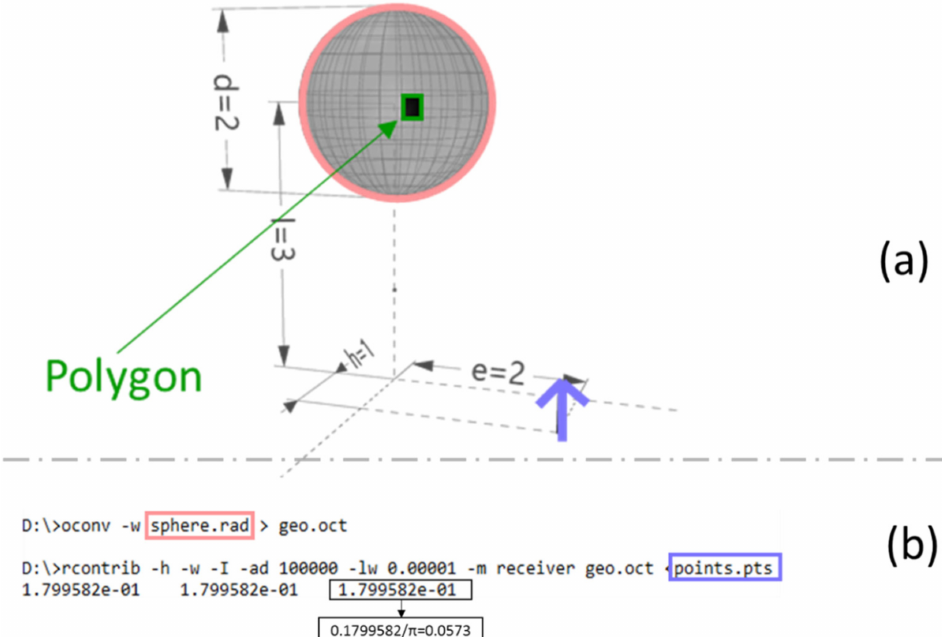
Figure 13. View factor between a differential planar element and a sphere as shown in ( a ) with the corresponding calculation in ( b ). The sphere considered for the calculation is comprised of 595 polygons. The sphere in ( a ) shows a reduced number of polygons to improve legibility of the figure.